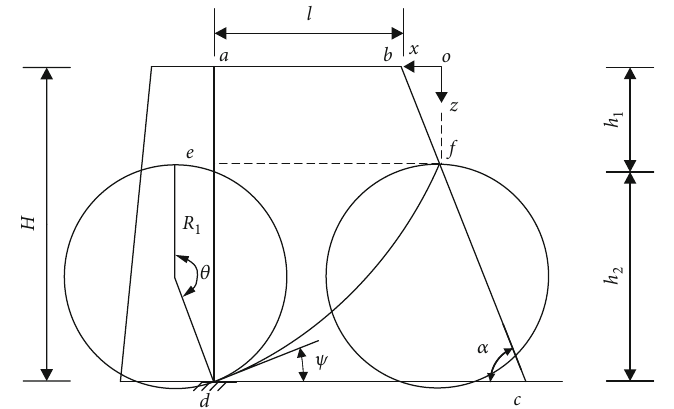
Figure 2: Slip surface through the slope